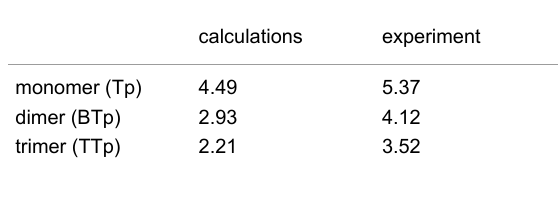
Table 1: Calculated HOMO–LUMO gaps for thiophene oligomers (in eV) compared with experimental values obtained by Diaz et al.